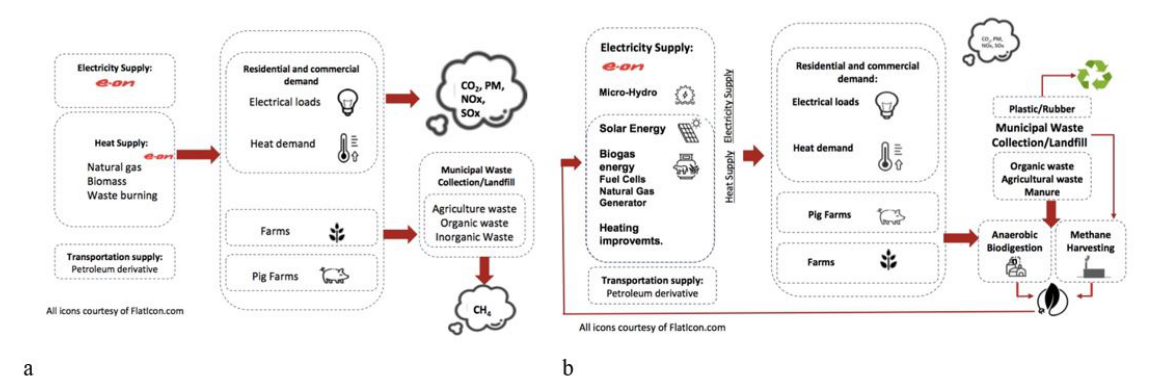
Figure 6. (a) Diagram of Existing Energy Flows (b) Diagram of Proposed